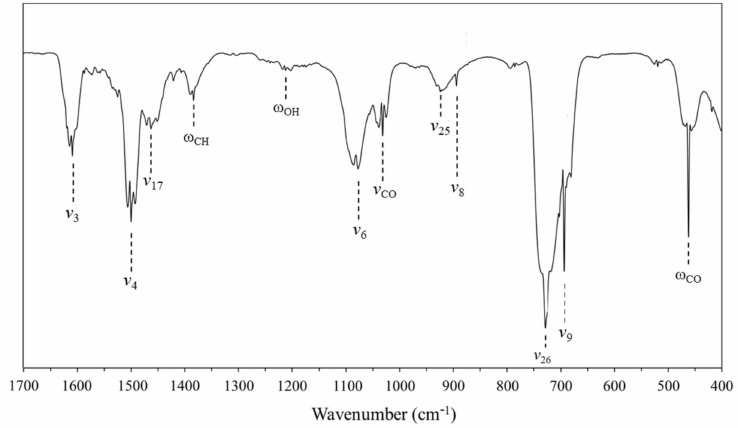
Figure 5. Observed vapor-phase infrared of 2CPOL for the 400–1700 cm − 1 region.